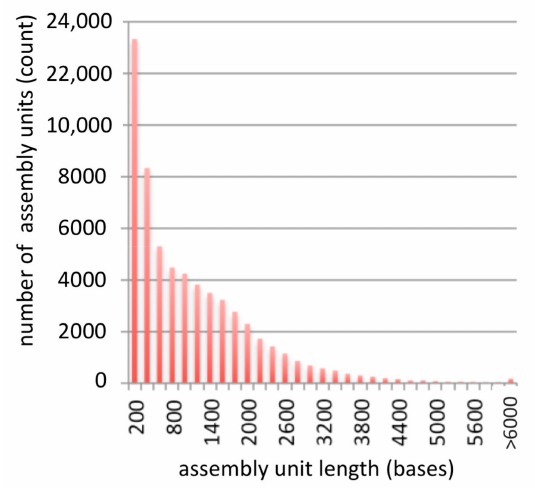
Figure 1. Length distribution of assembled